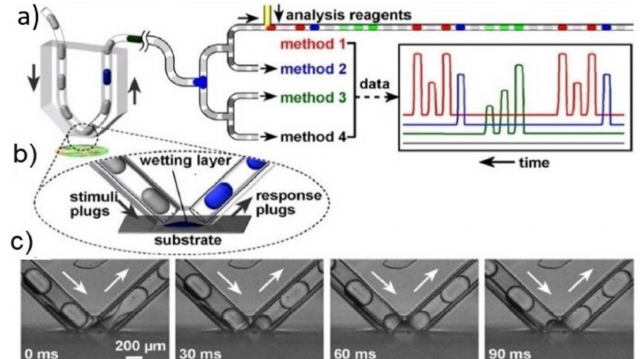
Figure 3. Pre-formed droplets are used to stimulate and extract analyte from a substrate, such as cell culture. ( a ) schematic of a device in operation; ( b ) an opening in the chip allows for droplet to merge with the hydrophilic substrate; ( c ) time-lapse bright-field images (side view) of the droplet extracting contents at 0 ms, 30 ms, 60 ms and 90 ms. (Reprinted with permission from Reference [10]. Copyright 2008 National Academy of Sciences, USA).